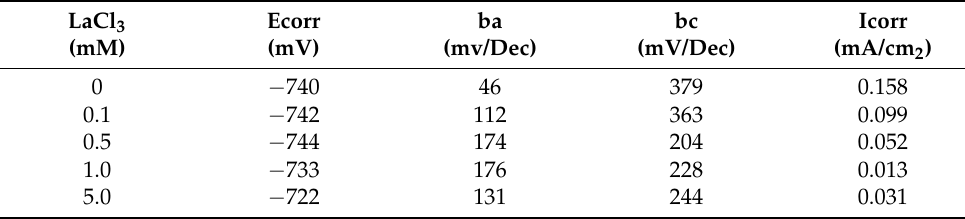
Table 1. Electrochemical parameters of the polarization curves. LaCl 3 Ecorr ba